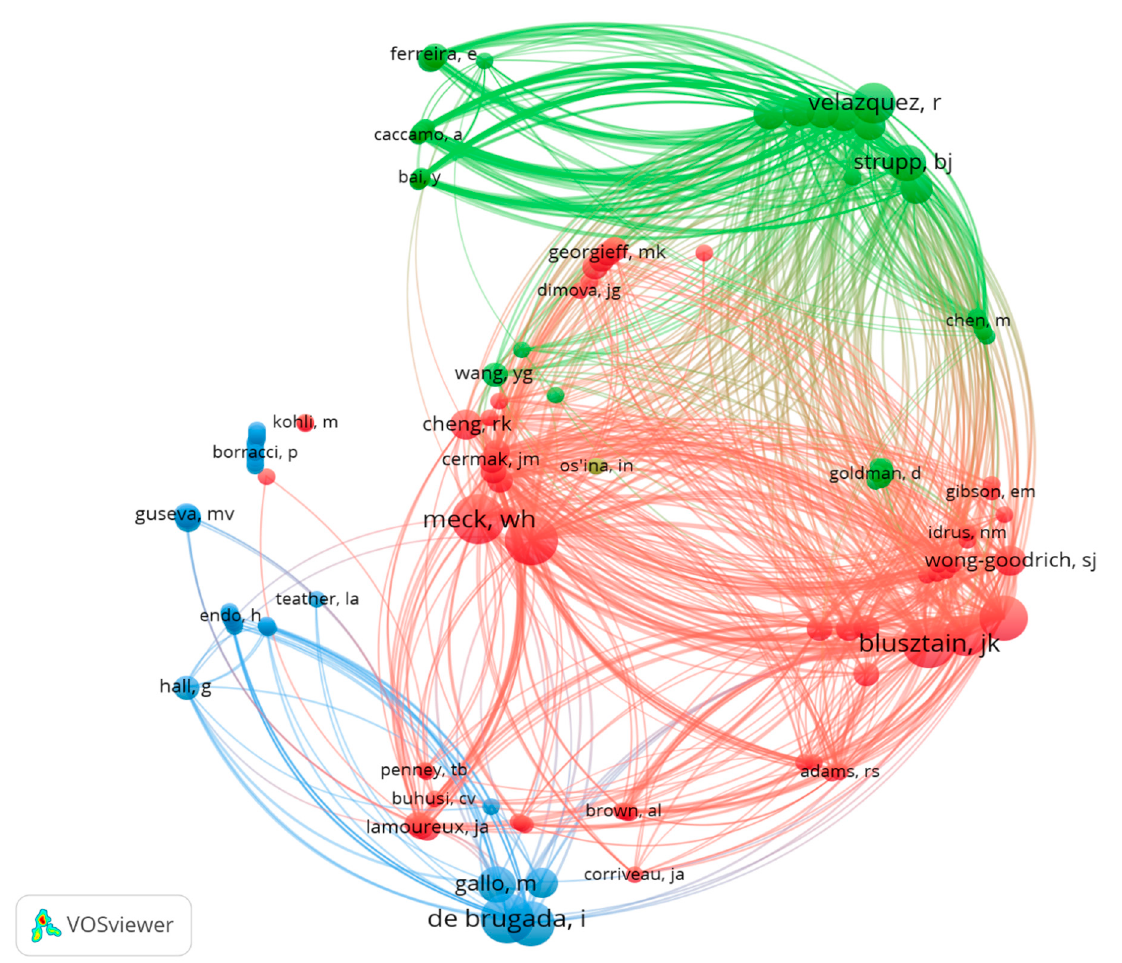
Figure 5. Network data map of the articles’ authorship indicating research groups and collaborations. Point size represents the number published articles. The colors and lines show clusters based on coauthorship.